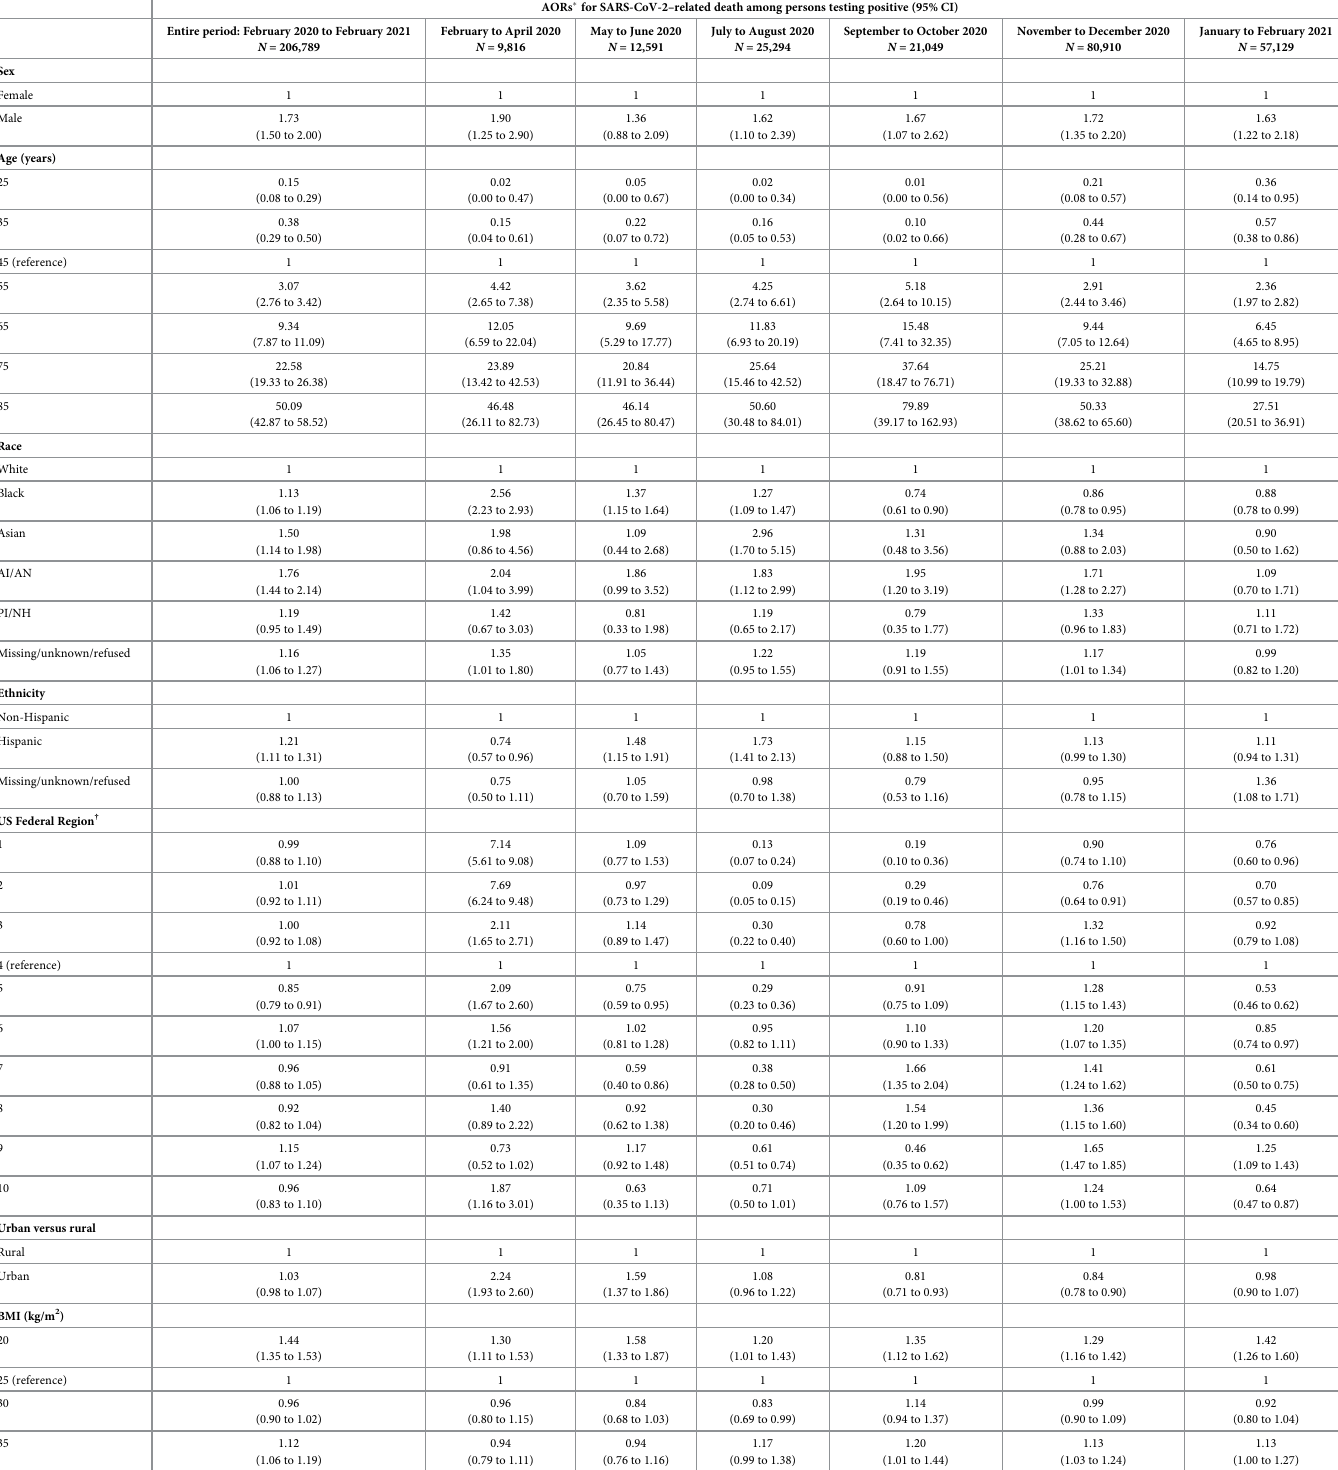
Table 6. Trends over time in the associations (AORs � ) of sociodemographic characteristics and comorbidity burden with risk of SARS-CoV-2 case fatality among 206,789 VA enrollees who tested positive for SARS-CoV-2 from February 1, 2020 to February 28, 2021, presented overall and divided into time